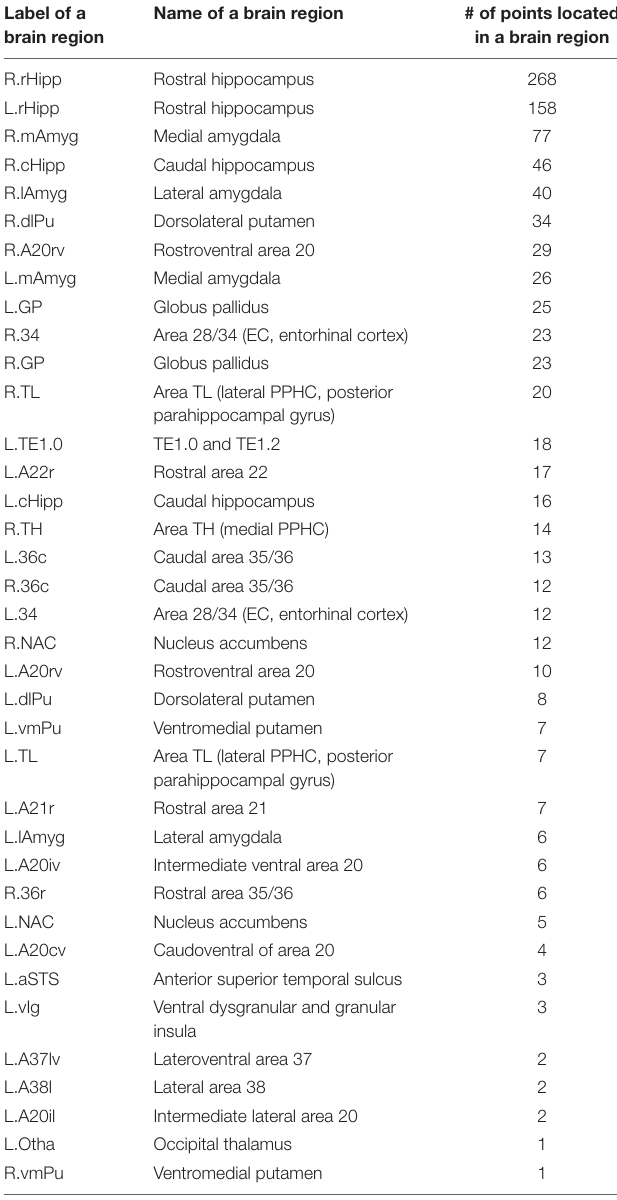
TABLE 8b | Details of the discriminable brain regions in the MCIc vs. HC TABLE 8a | Details of the discriminable brain regions in the AD vs. HC task. Label of a Name of a brain region # of points located brain region in a brain region